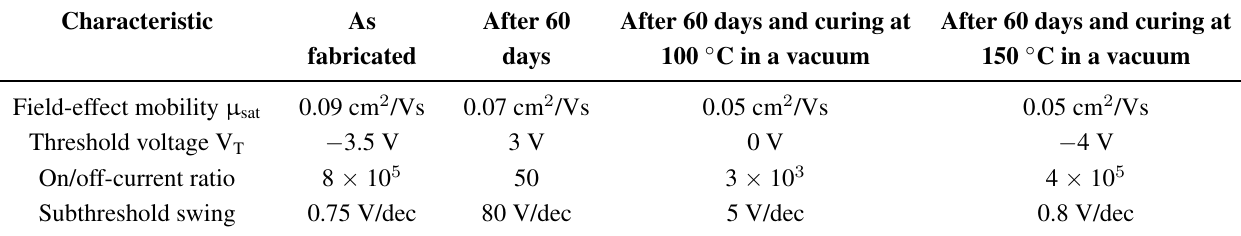
Table 2. Extracted parameters for µ -dispensed FS111 using SU-8 dielectrics on FOC as fabricated and after 60 days with and without curing at elevated temperatures in a